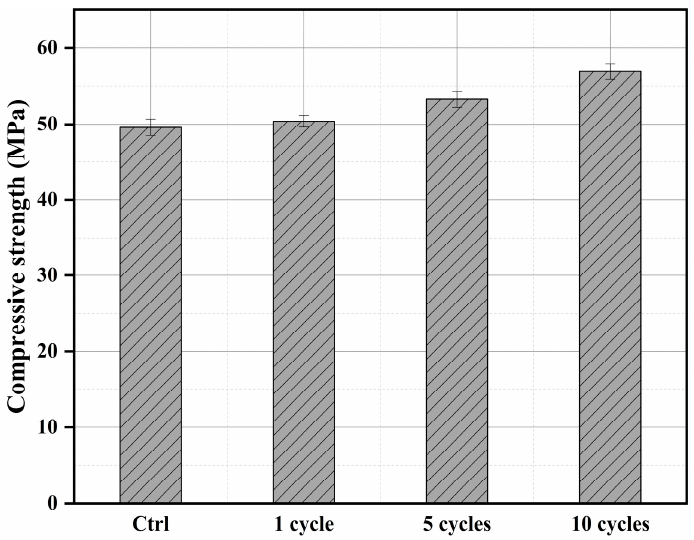
Figure 6. Compressive strengths of the Mongolian Scots pine at di ff erent cycles